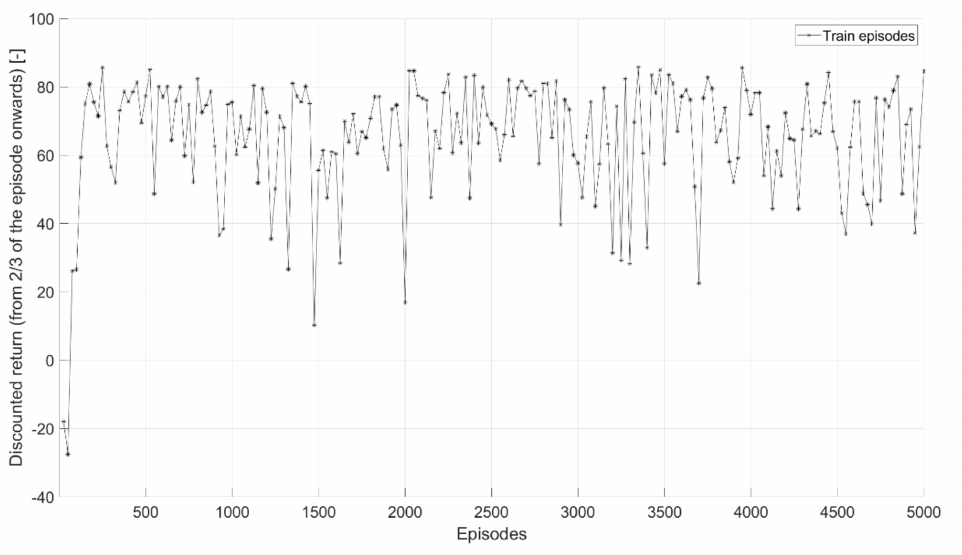
Figure 12. Discounted return of the training episodes calculated at 2/3 of the CLUST1 for γ = 0.9. Other meaningful trajectories for the problem of HEVs real-time control are repre- sented by the battery SoC and the cumulative FC realized by the RL agent over the driving mission. In Figures 13 and 14, the trends of the battery SoC evaluated in one of the first and the last episodes over CLUST1 are charted both for training and testing conditions, respectively. Evidently, the agent proves the capability of realizing a CS battery SoC trajec- tory at the end of the experiment, whereas a very poor control policy is highlighted at the beginning of the experiment. An interesting outcome is also represented by the difference between training and testing episodes. In fact, the final battery SoC of the last testing episode (0.5838) is closer to the reference value (0.6) with respect to the one obtained in the last training episode (0.5760). As far as the cumulative FC is concerned, Figures 15 and 16 highlight the agent capability of maintaining roughly the same FC during training and testing, respectively. This can be considered a consistent result of the training process since the achievement of improved CS trajectories is not affecting the final